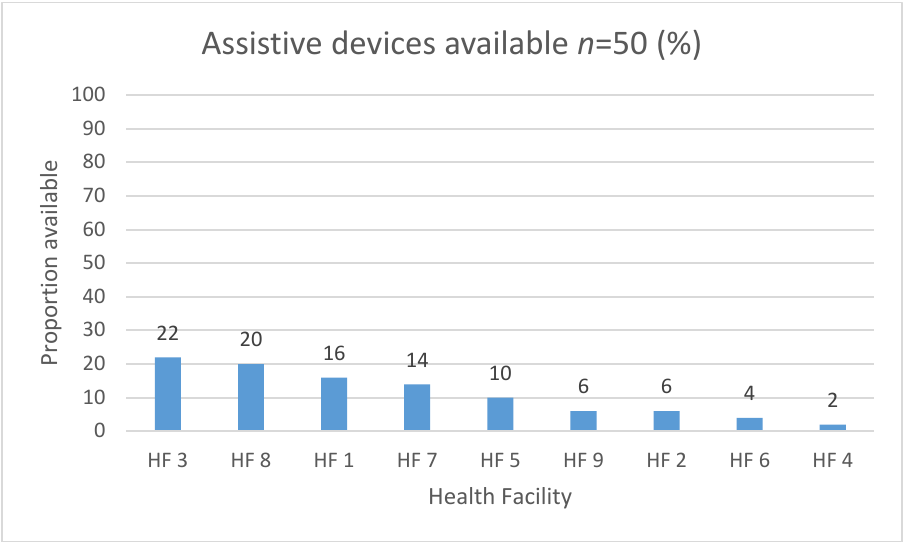
Figure 2. Availability of assistive devices by proportion according to the Global Co ‐ operative As ‐ sistive Technology (GATE) Assistive Products List (APL).